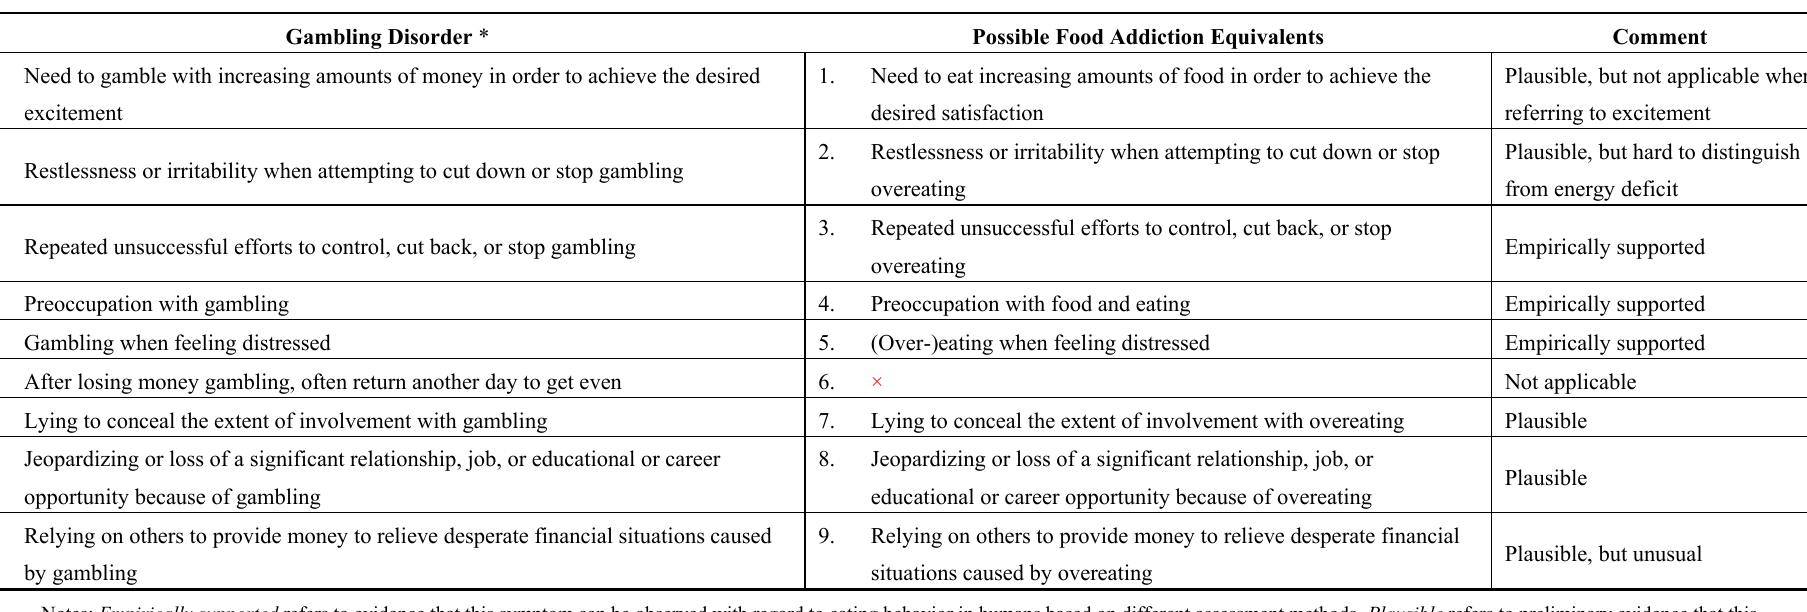
Table 2. Gambling disorder criteria according to the DSM-5 and possible corresponding food addiction